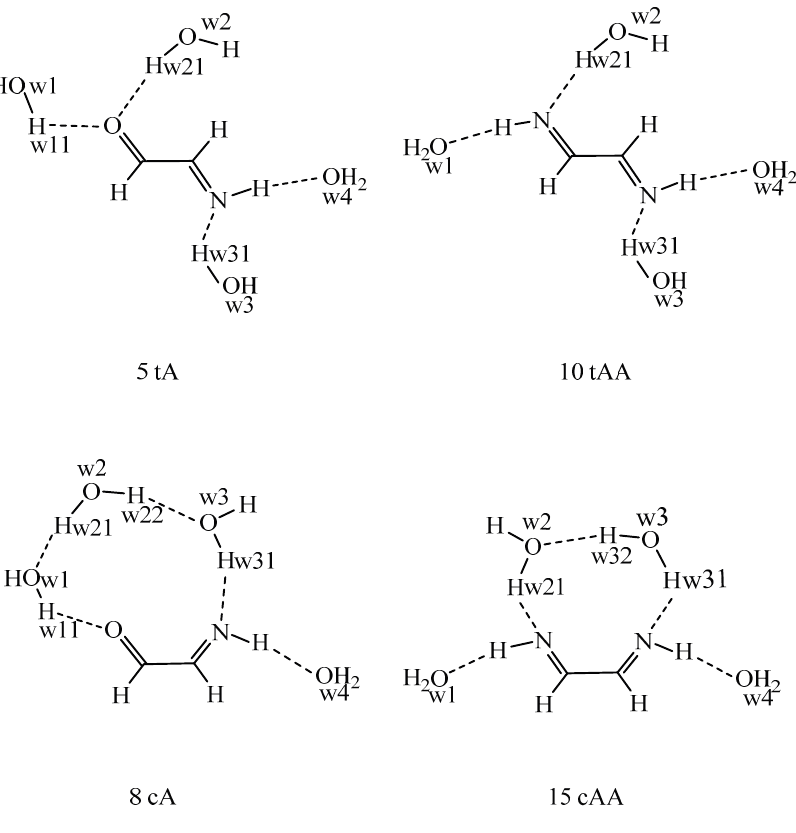
Figure 1. The structures of the tetrahydrates of the s-trans species 5 and 10 and the s-cis species 8 and 15 as optimized in continuum water solvent at the IEF-PCM/B97D/ aug-cc-pvtz level. The hydrogen bond parameters (from left to right) in Figure 1 are as follow. 5 tA: OCCN = 180°, the O=C, O…H w11 (198 pm), and O…H w21 (201 pm) bonds are coplanar, bond angles: O w1 H w11 …O = 177°, O w2 H w21 …O = 178°. The C=N, N–H and the N…H w31 (187 pm) bonds are coplanar, H…O w4 = 208 pm. The N…H w31 O w3 bond angle is 177°, N–H…O w4 = 173°. 10 tAA: NCCN = 179.9°, the N=C, N–H, and N…H w21 (187 pm) bonds are coplanar, H…O w1 = 209 pm. Bond angles: O w1… H–N = 173°, O w2 H w21 …N = 177°. The C=N, N–H and the N…H w31 (187 pm) bonds are coplanar, H…O w4 = 208 pm. The N…H w31 O w3 bond angle is 177°, N–H…O w4 = 173°. 8 cA: OCCN = 23.7°, only one water—carbonyl hydrogen bond: O…H w11 (194 pm), O w1 H w11 …O = 161°. Waters 1 and 2 form a solvent-solvent hydrogen bond with O w1 …H w21 distance of 194 pm and O w1 …H w21 O w2 angle of 177°. Water 2 and water 3 are also linked by a solvent-solvent hydrogen bond: H w22 …O w3 = 187 pm and O w2 H w22 …O w3 = 177°. The C=N, N–H and the N…H w31 (186 pm) bonds are almost coplanar (the sum of the bond angles is 359°), H…O w4 = 201 pm. The N…H w31 O w3 bond angle is 178°, N–H…O w4 = 176°. 15 cAA: NCCN = 30.5°, the N=C, N–H, and N…H w21 (182 pm) bonds are coplanar, H…O w1 = 207 pm. Bond angles: O w1… H–N = 176°, O w2 H w21 …N = 177°. Water 2 and water 3 form a solvent–solvent hydrogen bond: O w2 …H w32 = 193 pm and O w2 …H w32 O w3 = 161°. The C=N, N–H and the N…H w31 (190 pm) bonds are coplanar, H…O w4 = 210 pm. The N…H w31 O w3 bond angle is 175°, N–H…O w4 =